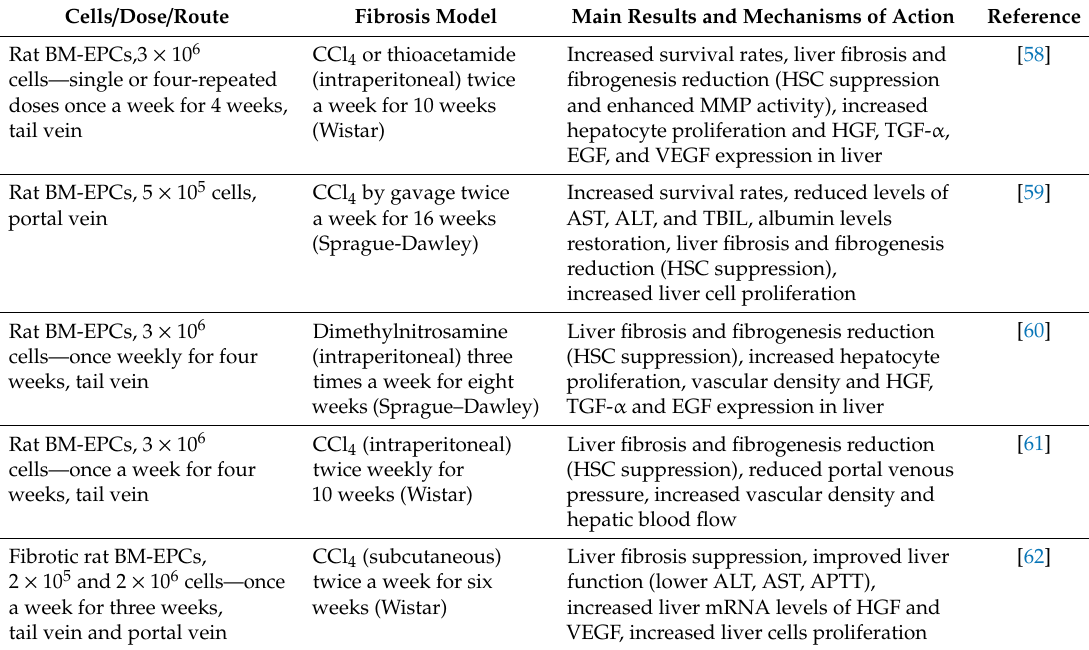
Table 3. Experimental liver fibrosis and endothelial progenitor